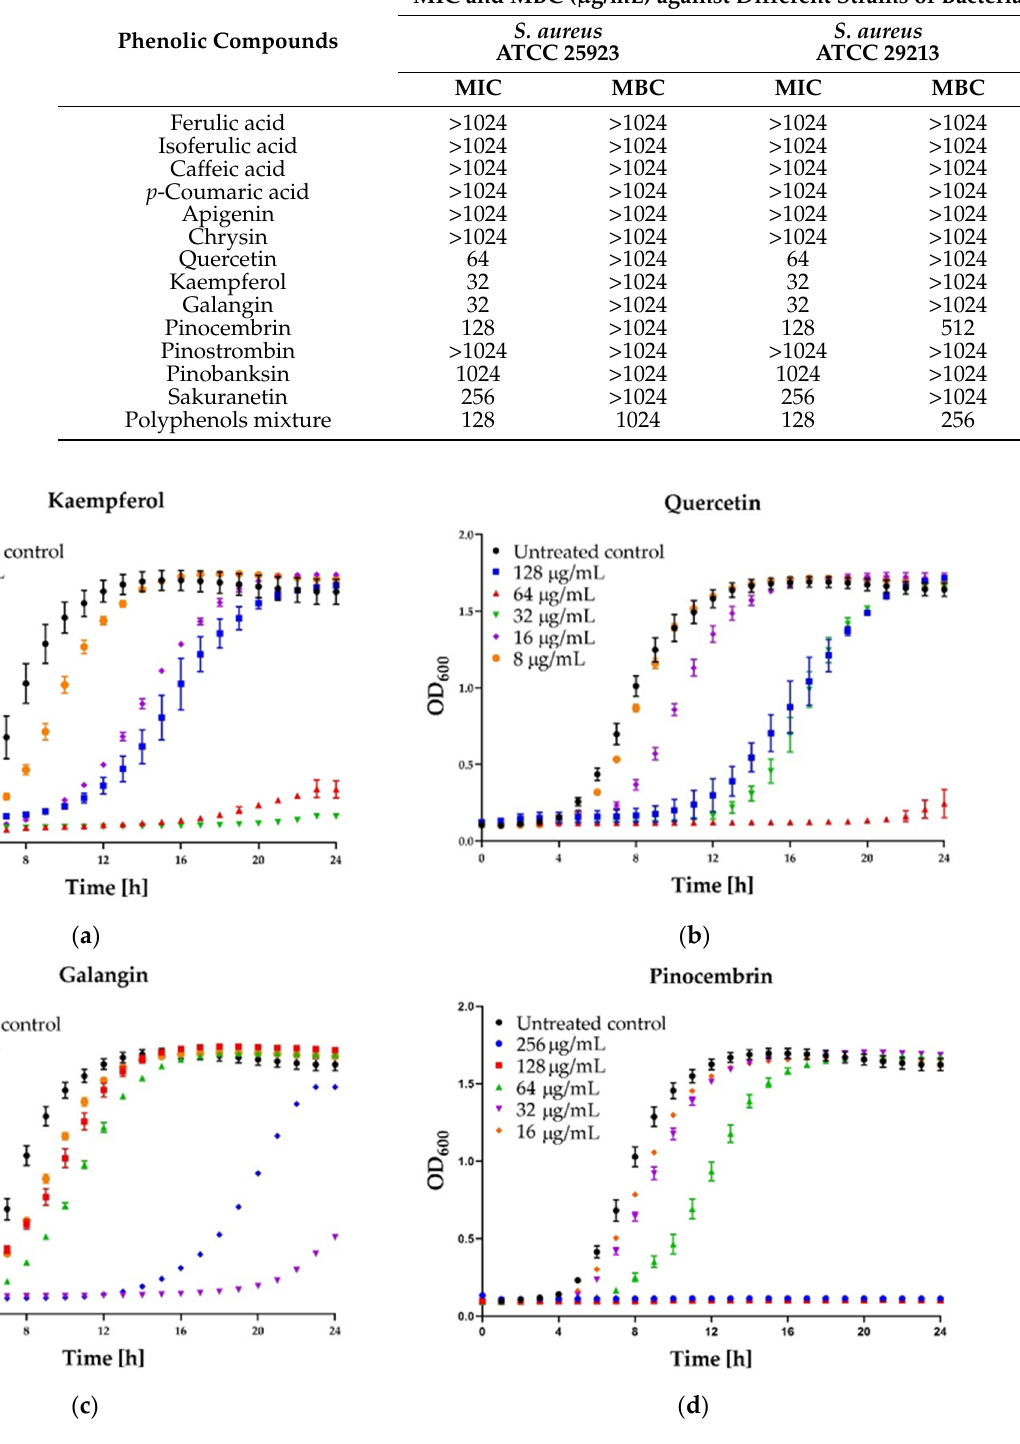
Figure 4. Growth curve assay for selected polyphenols tested against S. aureus ATCC 25923 at different concentrations. The growth control contained no antimicrobial compound. ( a ) Kaempferol; ( b ) Quercetin; ( c ) Galangin; ( d ) Pinocembrin. The results are presented as means ± SD ( n = 3). Data without error bars indicate that the SD is too small to be observed on the graph.